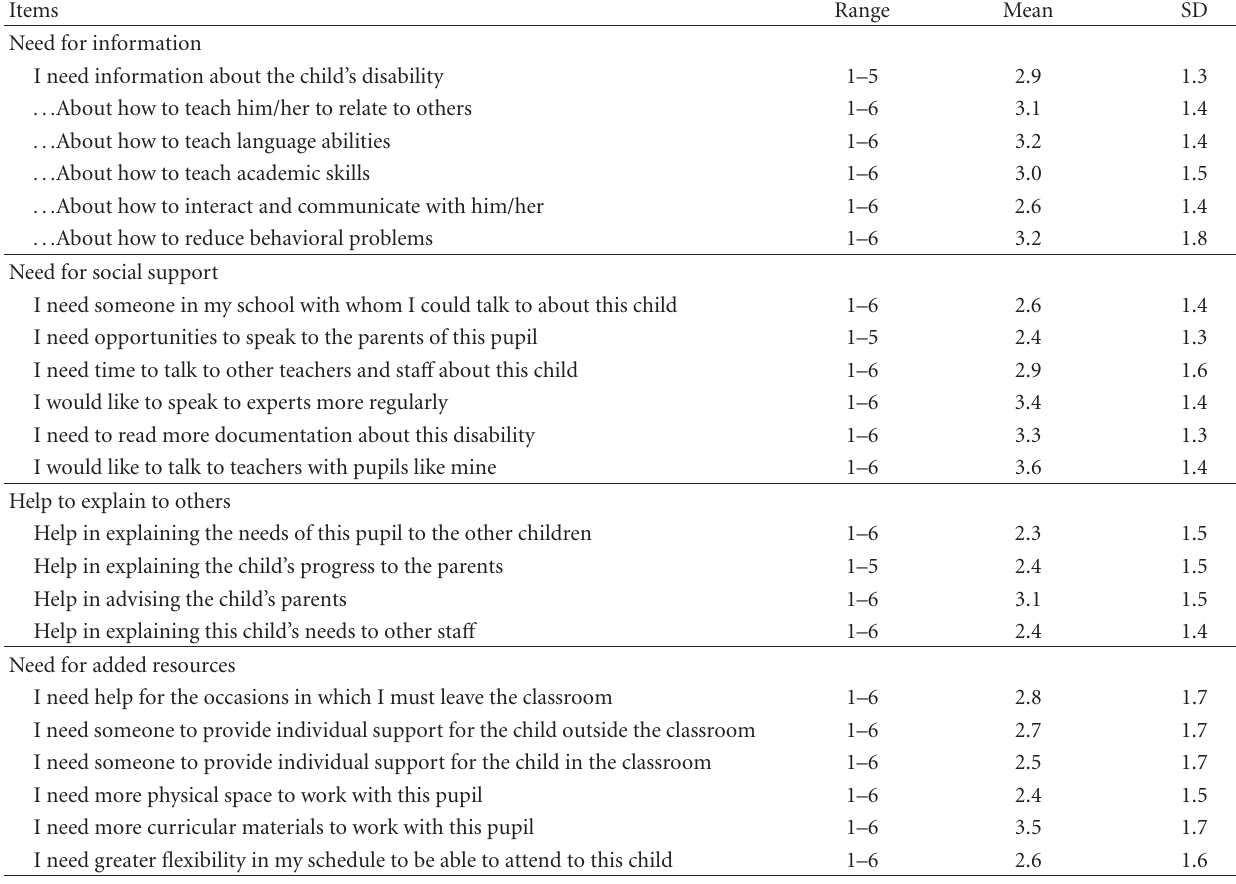
Table 4: Mean and standard deviation of the items of the needs questionnaire ( N = 69).